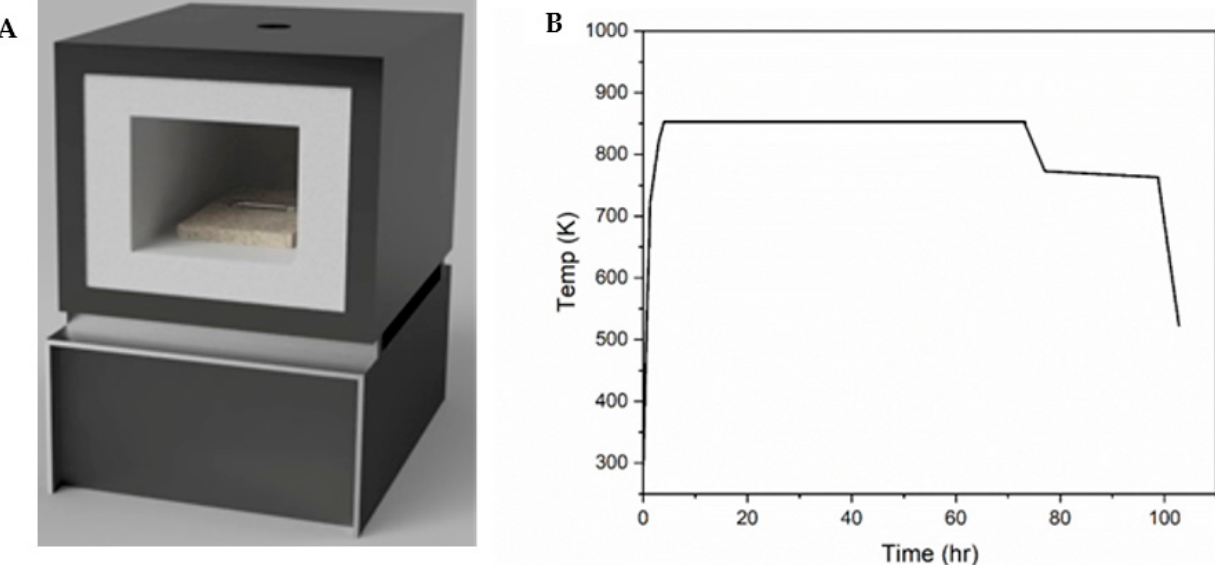
Figure 1. Reaction ampoules were oriented orthogonally to the heating elements in the walls of the muffle furnace ( A ) and the typical heating/cooling curve associated with Cu 2 P 3 I 2 ( B ).